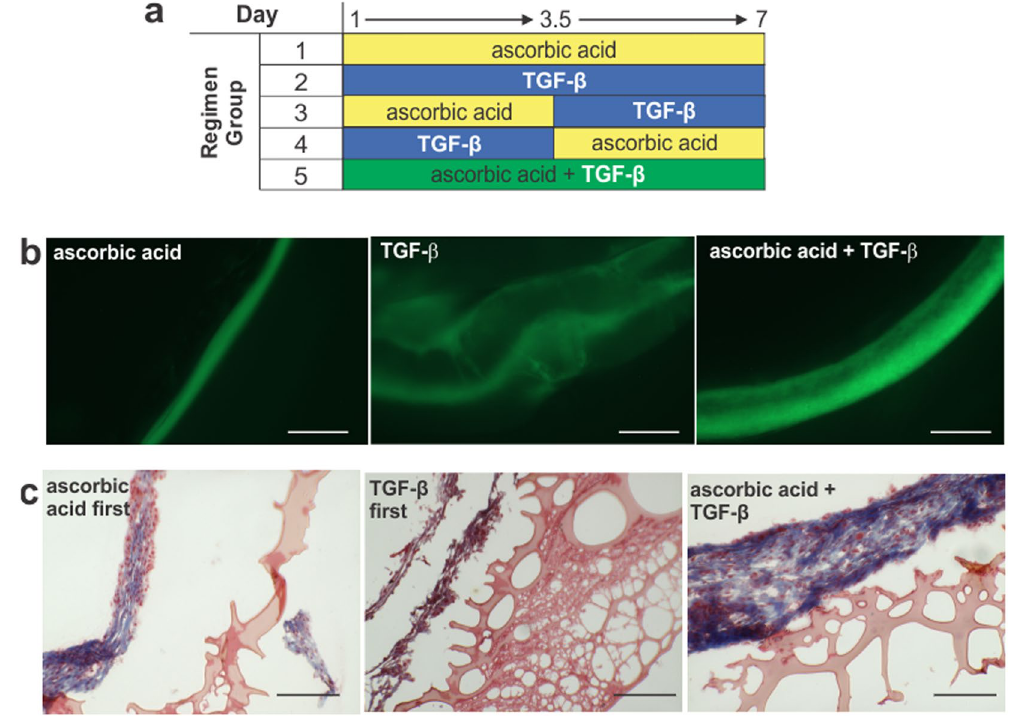
Figure 2. Cytokine regimen requires both ascorbic acid and TGF- β for adventitia ring formation. ( a ) Diagram of the five cytokine simulation regimens. ( b ) Images of fibroblast rings on day 8 under GFP light to visualize collagen auto-fluorescence with three different growth factor stimulations of groups: 1 (ascorbic acid only), 2 (TGF- β only) and 3 (combined ascorbic acid and TGF- β ). Ascorbic acid only resulted in thin rings; TGF- β only resulted in loose rings. Combination rings resulted in thicker, robust rings. Scale bars = 500 µ m. ( c ) Trichrome staining of adventitia ring cross-sections of groups: 3 (ascorbic acid first), 4 (TGF- β first) and 5 (ascorbic acid and TGF- β simultaneously). Combined stimulation throughout the ring formation resulted in the thickest, most robust rings with significant collagen content (blue/purplish stain). Scale bars = 200 µ